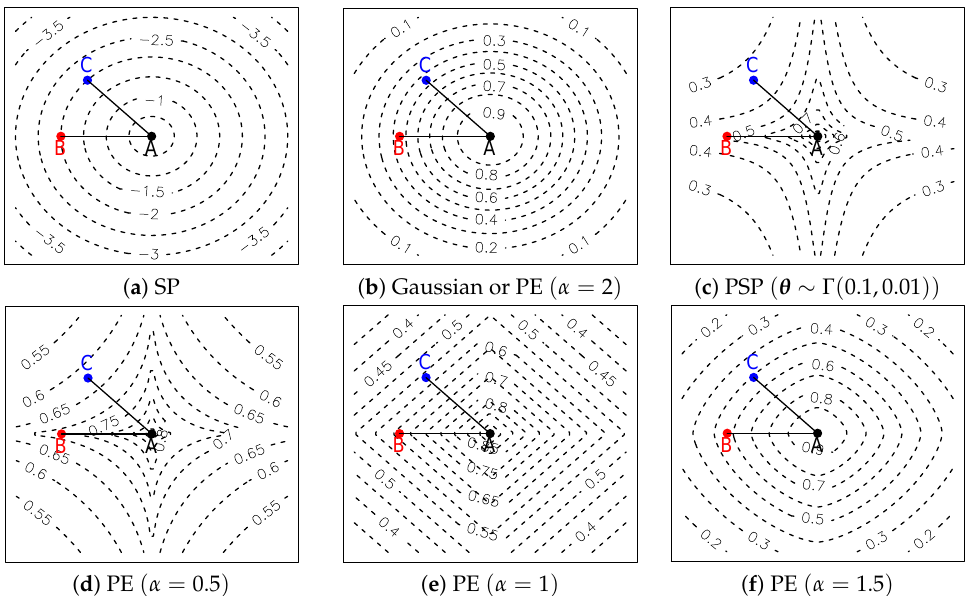
Figure 1. Contours of different kernels. ( a ) Negative Euclidean distance kernel in support points (SP) method; ( b ) Gaussian kernel; ( c ) sparsity-inducing kernel in projected support points (PSP) method; ( d – f ) power exponential (PE) kernel with α = 0.5,1,1.5, respectively. The point A and point B in